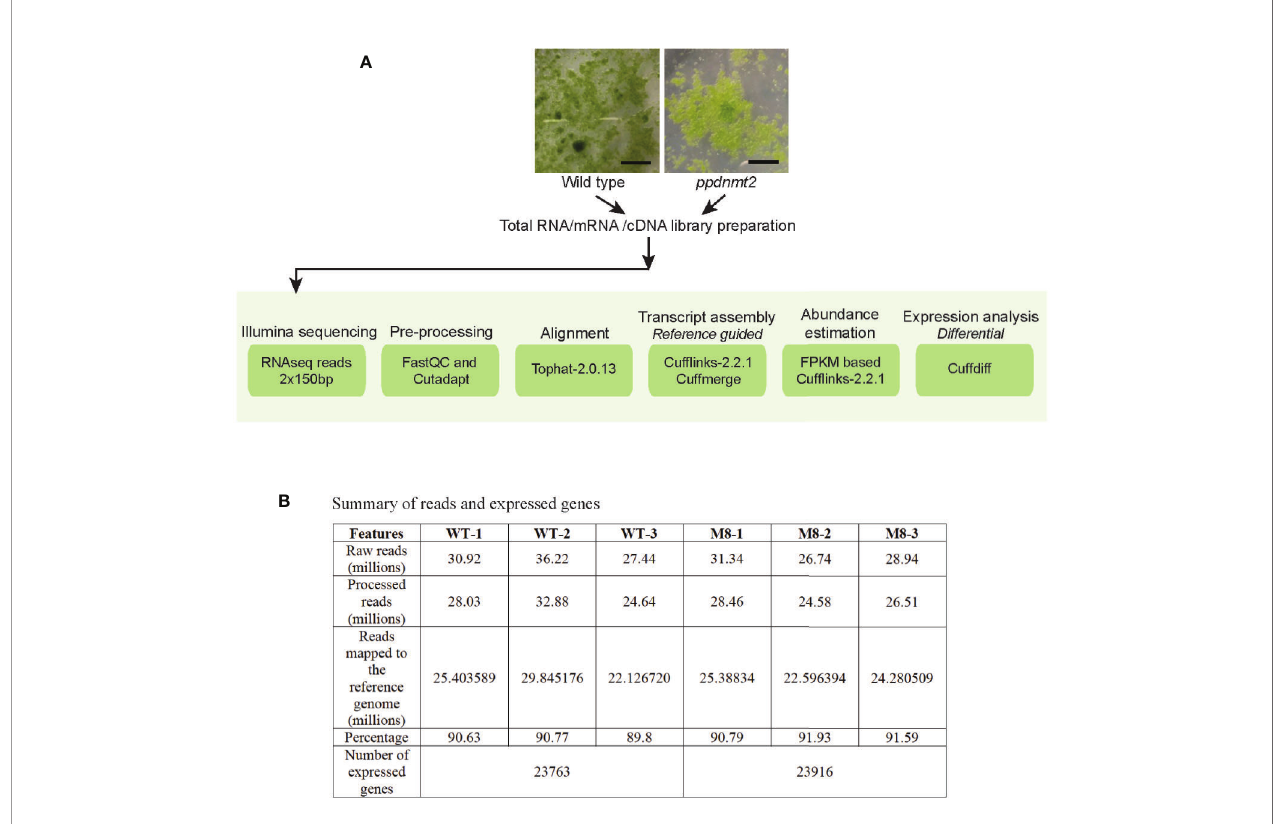
FIGURE 1 | (A) Outline of RNA sequencing strategy employed for identi fi cation of differentially expressed genes in PpDNMT2 knockout plants . (B) Table summarizing statistics of reads generated in sequencing and their assembly. Scale bar = 1